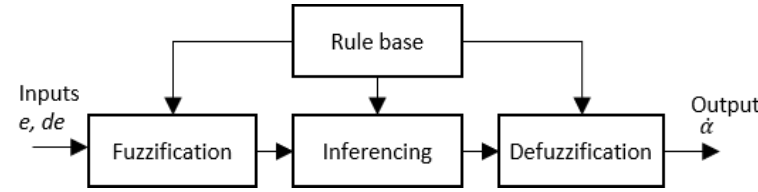
Figure 13. The architecture of the fuzzy logic system.